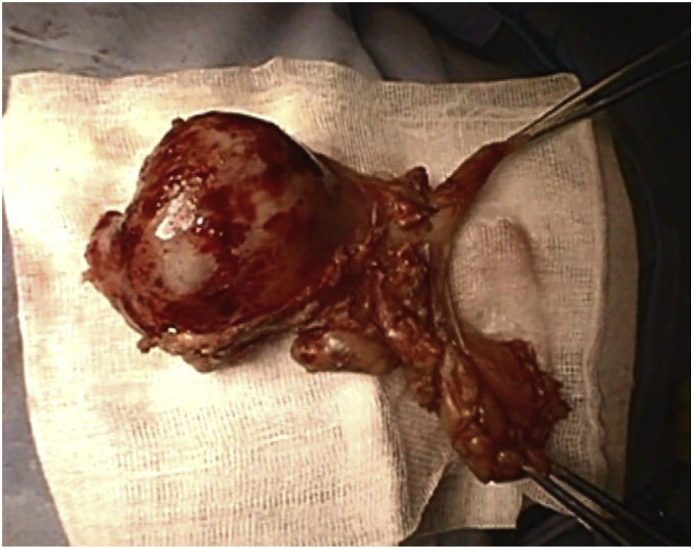
Removed thymoma.